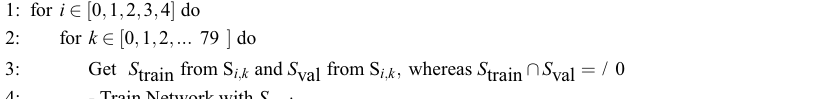
Fig. 3 Workflow of our approach: The goal is to find a 2D CNN that maps three images to their corresponding rotation matrix with suf- ficient accuracy. The numbers in the solid black circles indicate the order: (1) The volume is rotated with a rotation matrix R . (2) The three summed volume projections from the randomly oriented rivet are passed to the network. (3) The network predicts a rotation